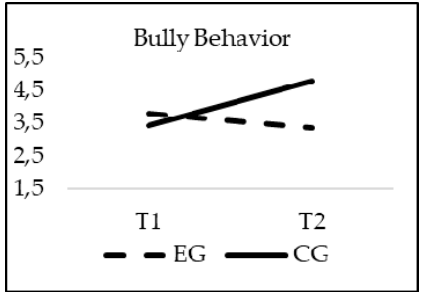
Figure 1. Interaction effects of group (EG-CG) and time (T1-T2) in Bully Behavior.